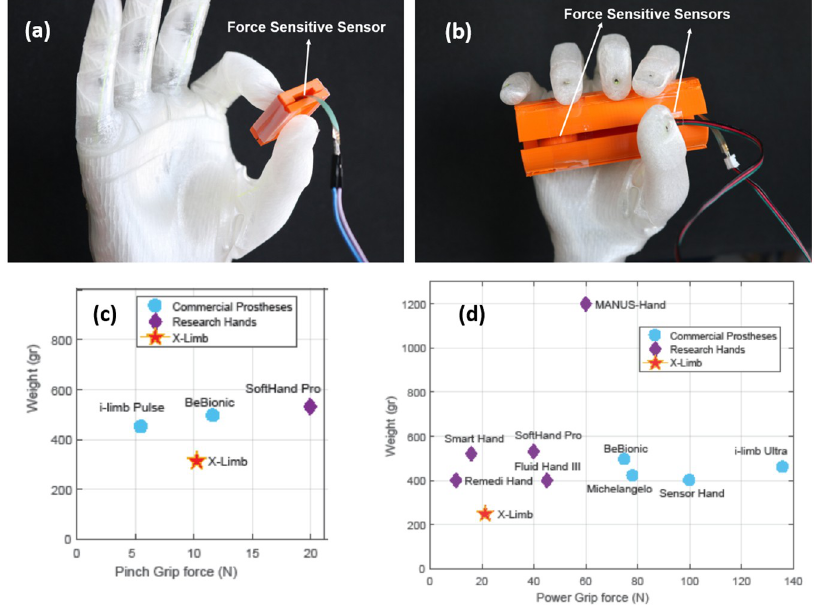
Fig 8. Power and pinch grip force measurement: (a) Measurement setup of pinch grip force; (b) Measurement setup of power grip force. Distribution of hand weight compared with grip force of existing commercial and research hand prostheses for: (c) pinch grasp and (d) power